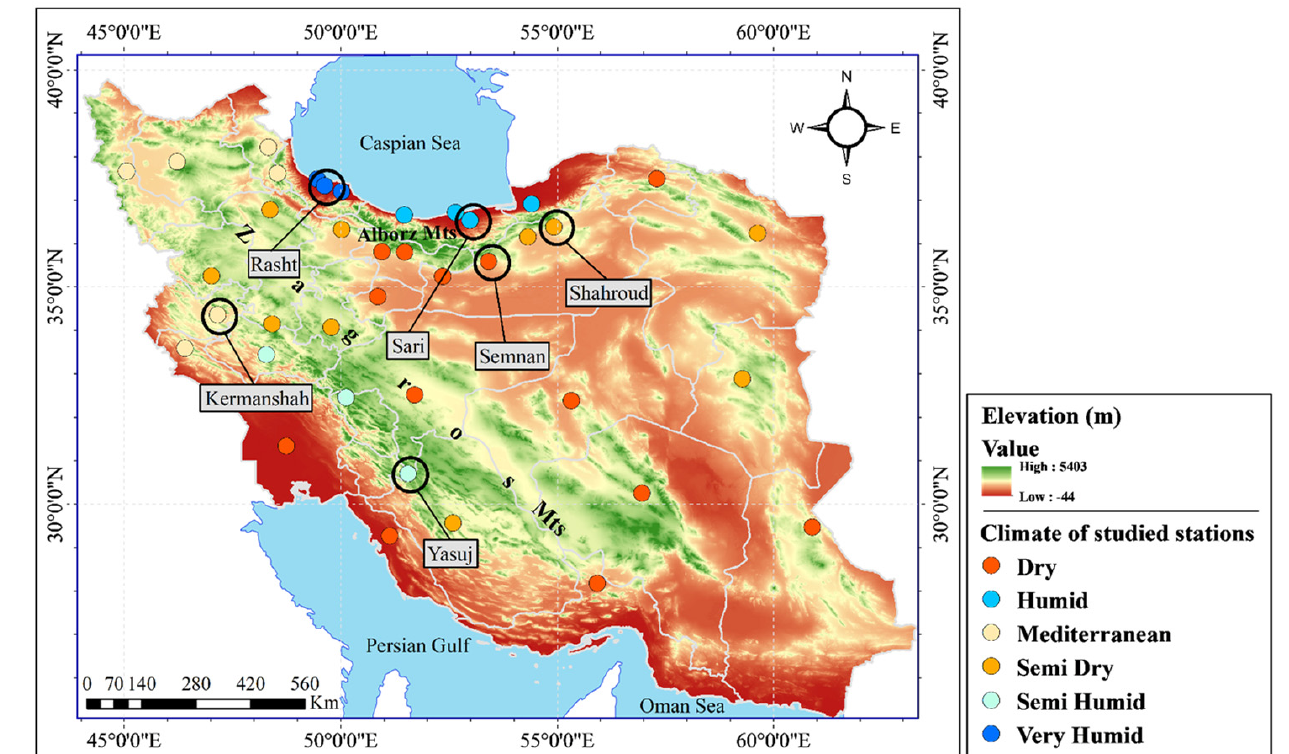
Figure 1. Location of the selected synoptic weather stations in Iran from which data were obtained. (For more information about the synoptic weather stations, see Table S4 in Supplementary Material.).